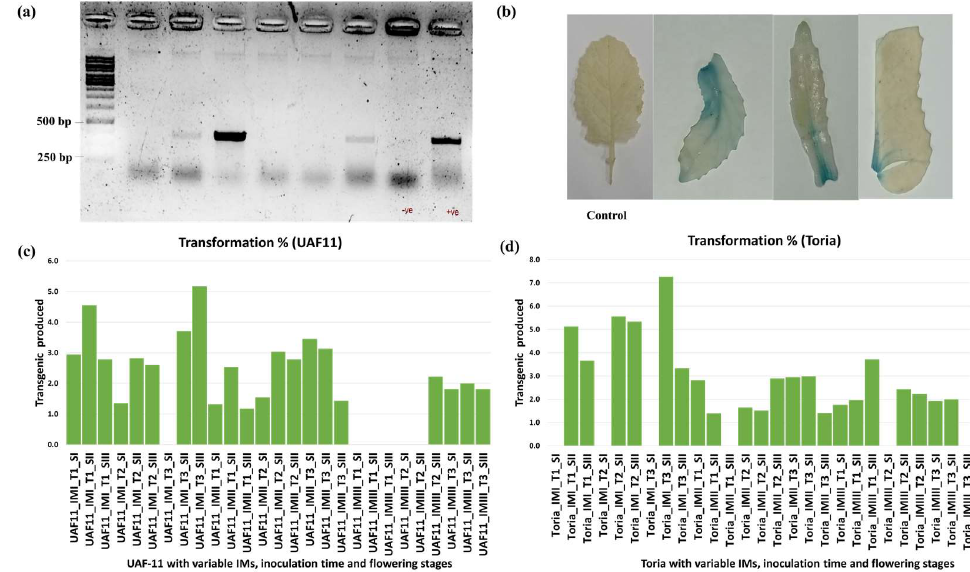
Table 2. Composition of the IM used in the experiment.